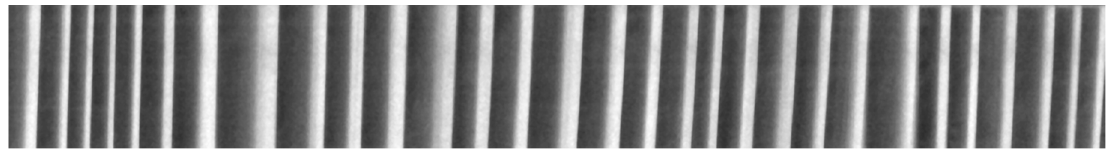
Figure 10. Composite density image of a spruce sample (radial/longitudinal section). Brightness is proportional to density.